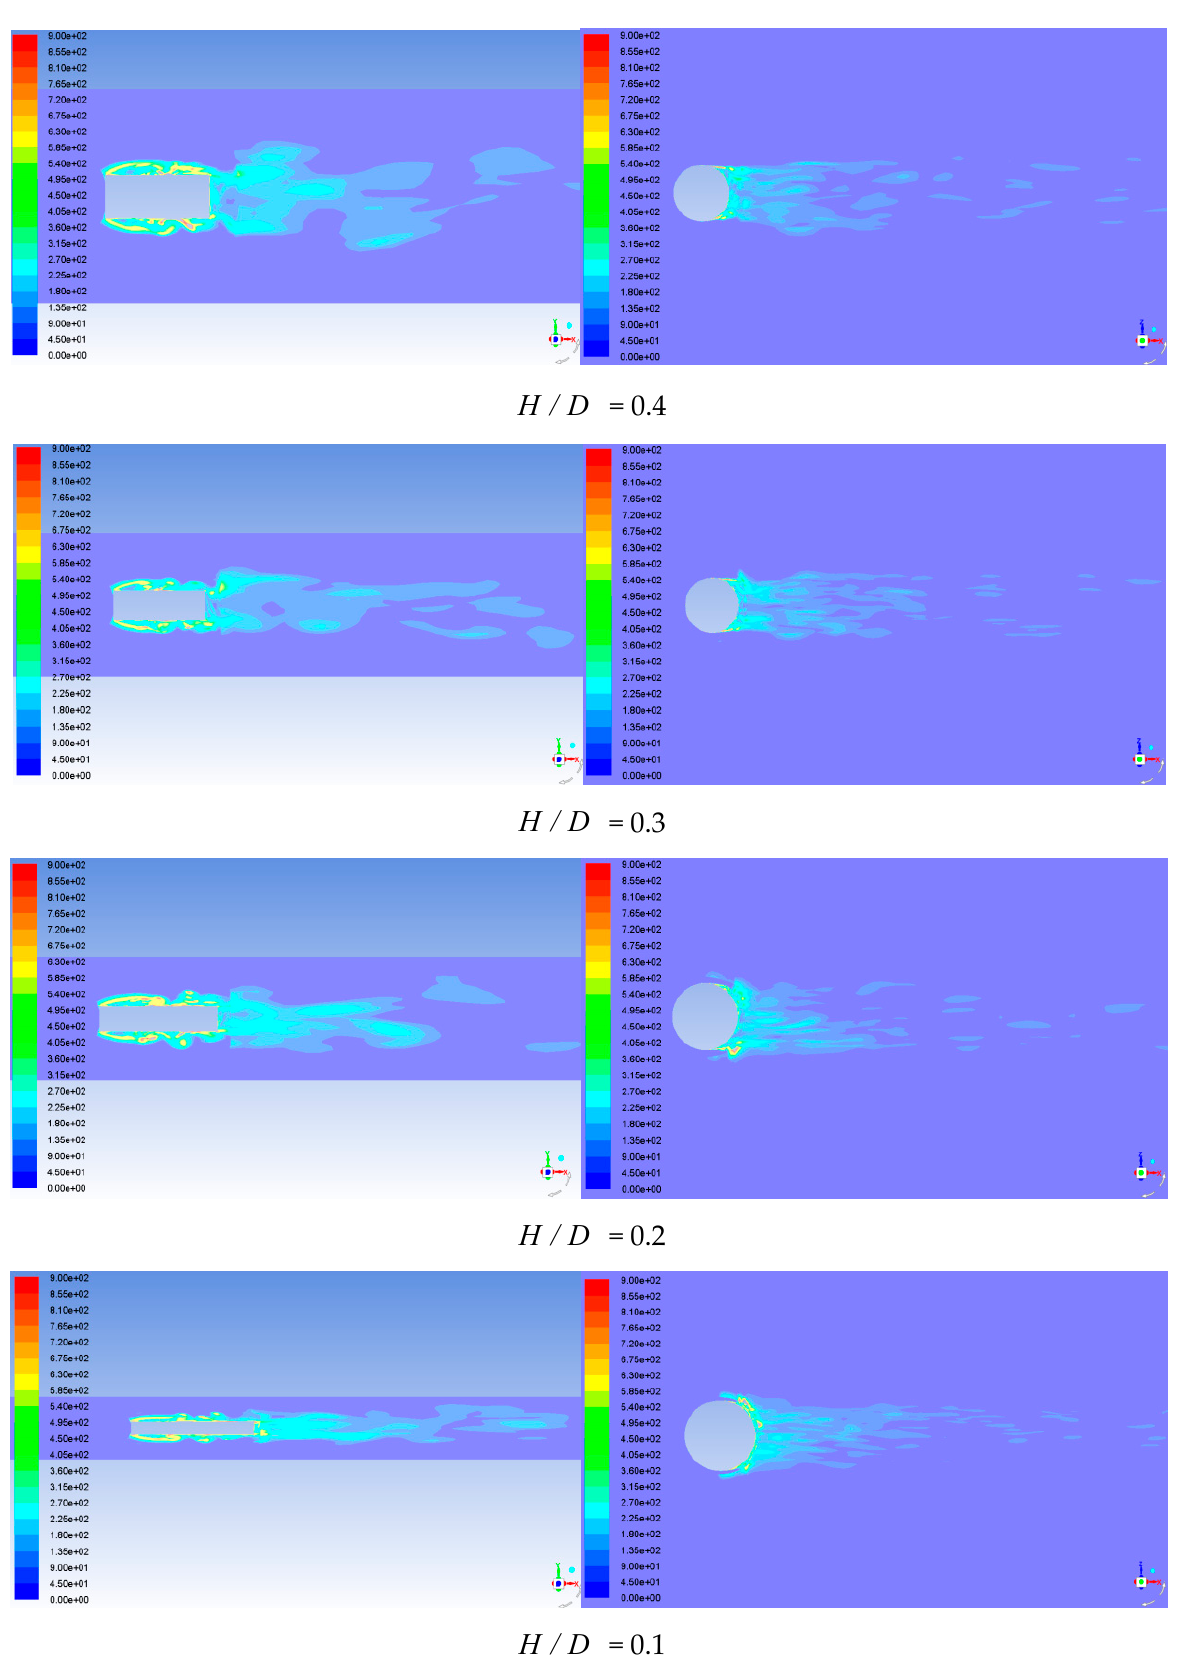
Figure 9. Contours of vorticity in the vertical center plane at z / D = 0 and the horizontal center plane at y / D = 0 with different aspect ratios. For DH / = 0.6 and DH / = 0.5, we can still observe apparent vortex shedding in the rear area of the circular cylinder, but the scale of the shedding vortex is already very small. The vortical structures in this condition are significantly less vigorous than those in the case of 0.5/7.0 ≤≤ DH .